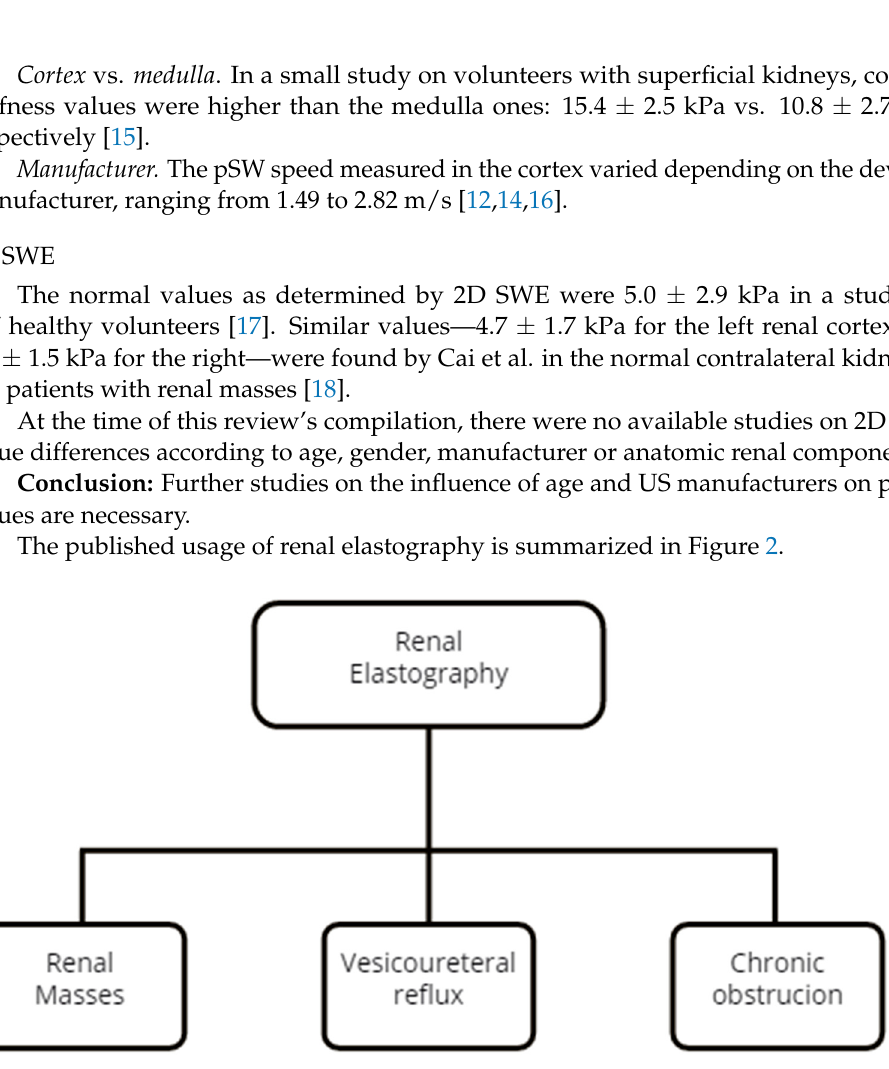
Figure 2. Renal pathologies assessed by